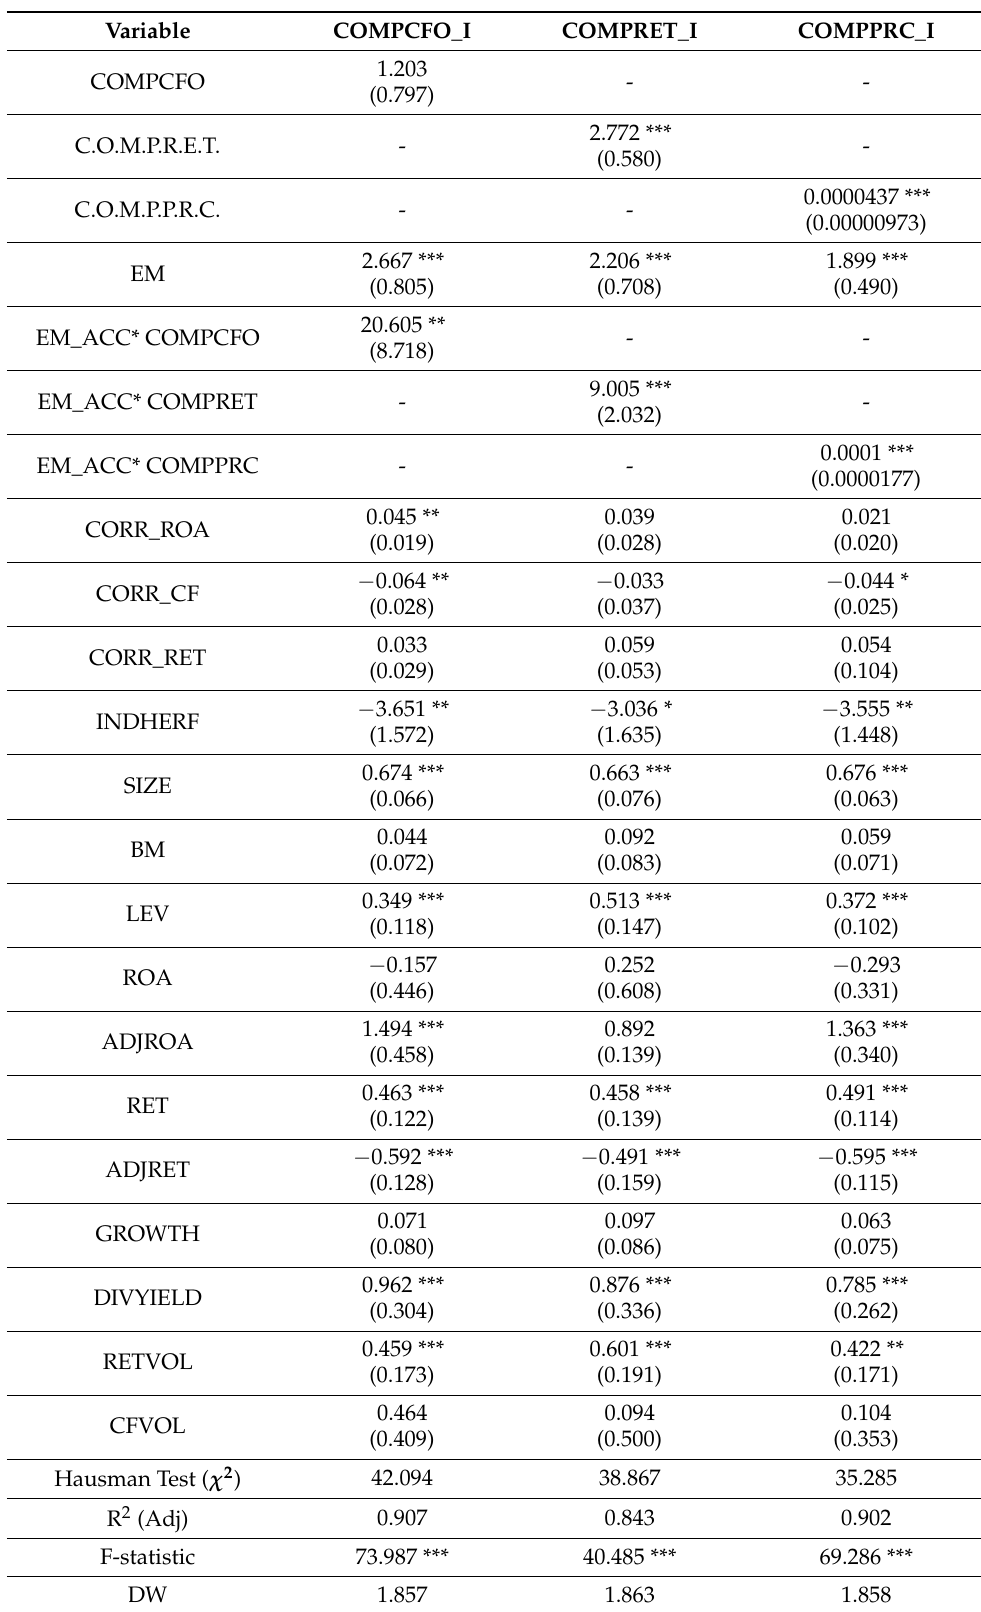
Table 6. Accruals earnings management and accounting